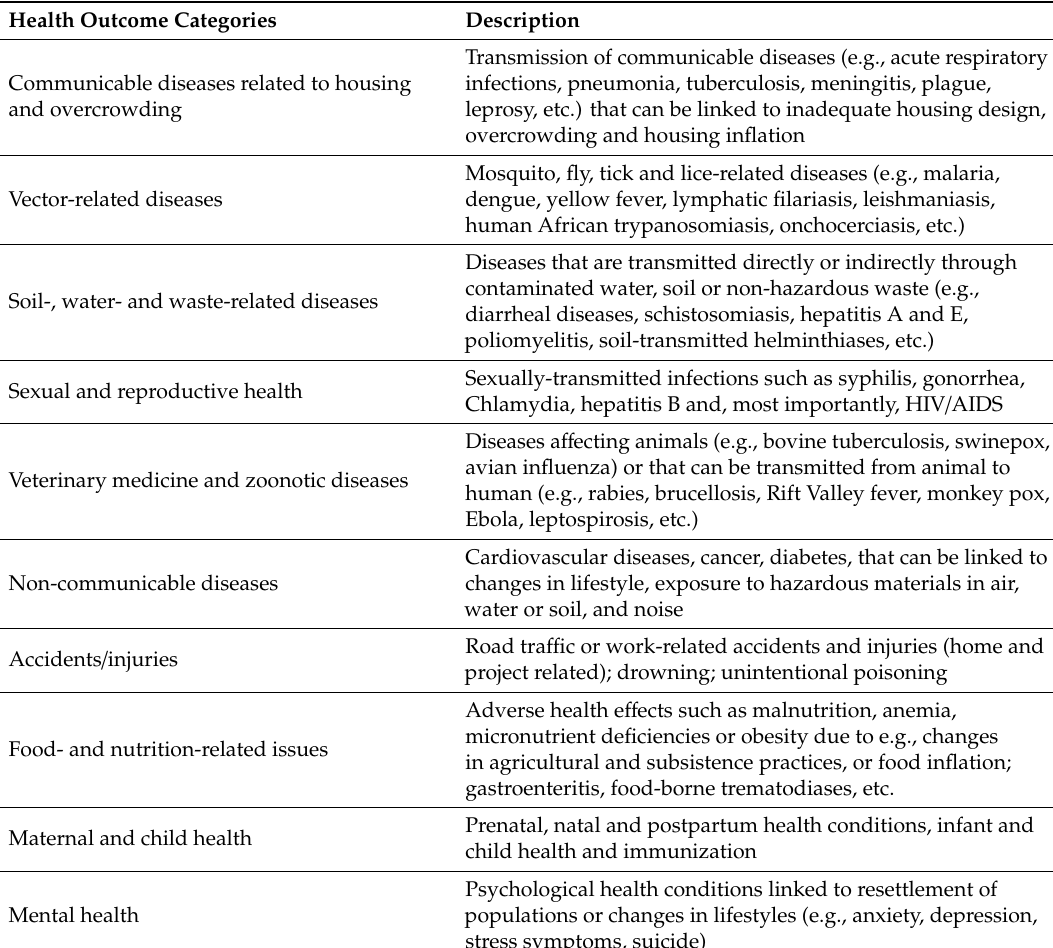
Table A2. Health outcome